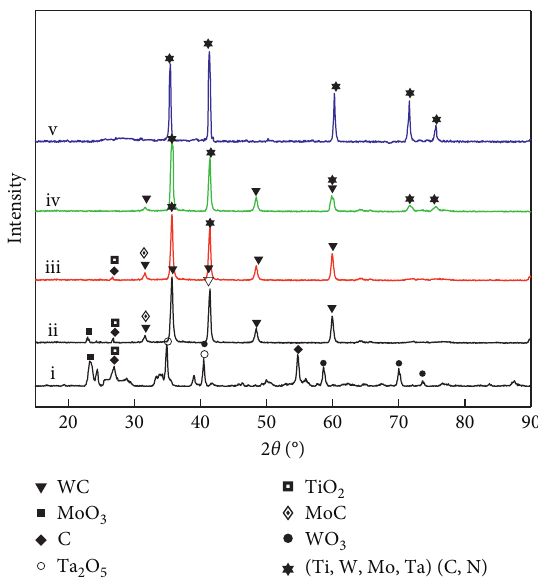
Figure 4: X-ray diffraction patterns of solid solution powders at different sintering temperatures: (i) 20 ° C; (ii) 900 ° C; (iii) 1100 ° C; (iv) 1450 ° C; (v) 1500 ° C.